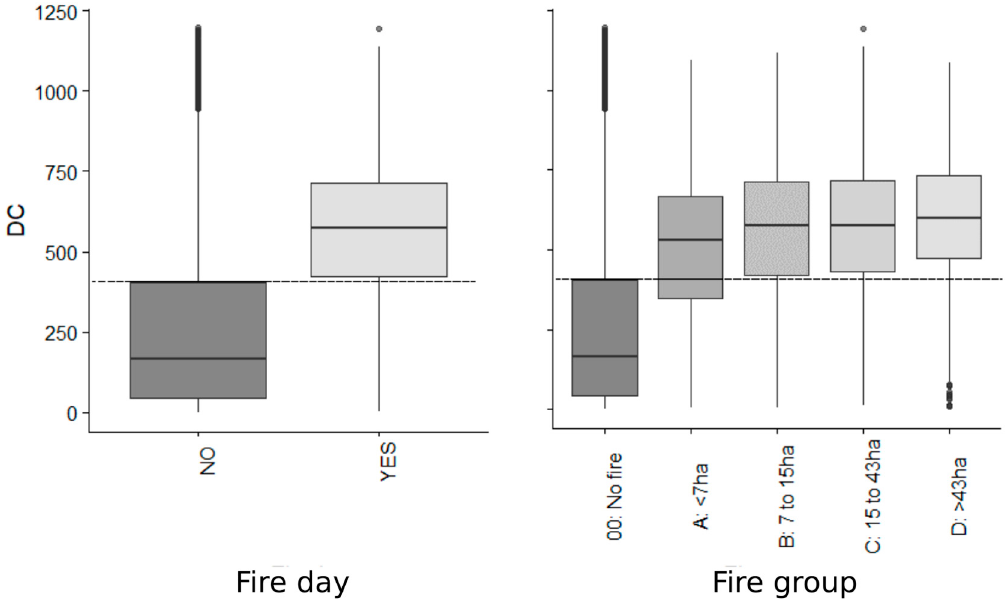
Figure 2. Comparisons of Drought Code (DC) distributions between days with or without fire reported (left panel, t -test, p > 0.001) and among increasing fire size classes (defined from the distribution quartiles) as compared to the no-fire class (right panel, first class). For both panels, fires and related day conditions were extracted from the Prométhée database. The horizontal dotted line in each panel corresponds to the chosen DC threshold (405 units) in order to calculate the fire-season length. It excludes 75% of the no-fire-days and includes 78% of the fire-days. Monthly means of daily DC (i.e., DCmean) over the 1979–2016 period and for each month of the fire-season (April–October) were compared to the MDC values computed over the same months and period. DCmean values were slightly higher than MDC values, yet their relationship (linear